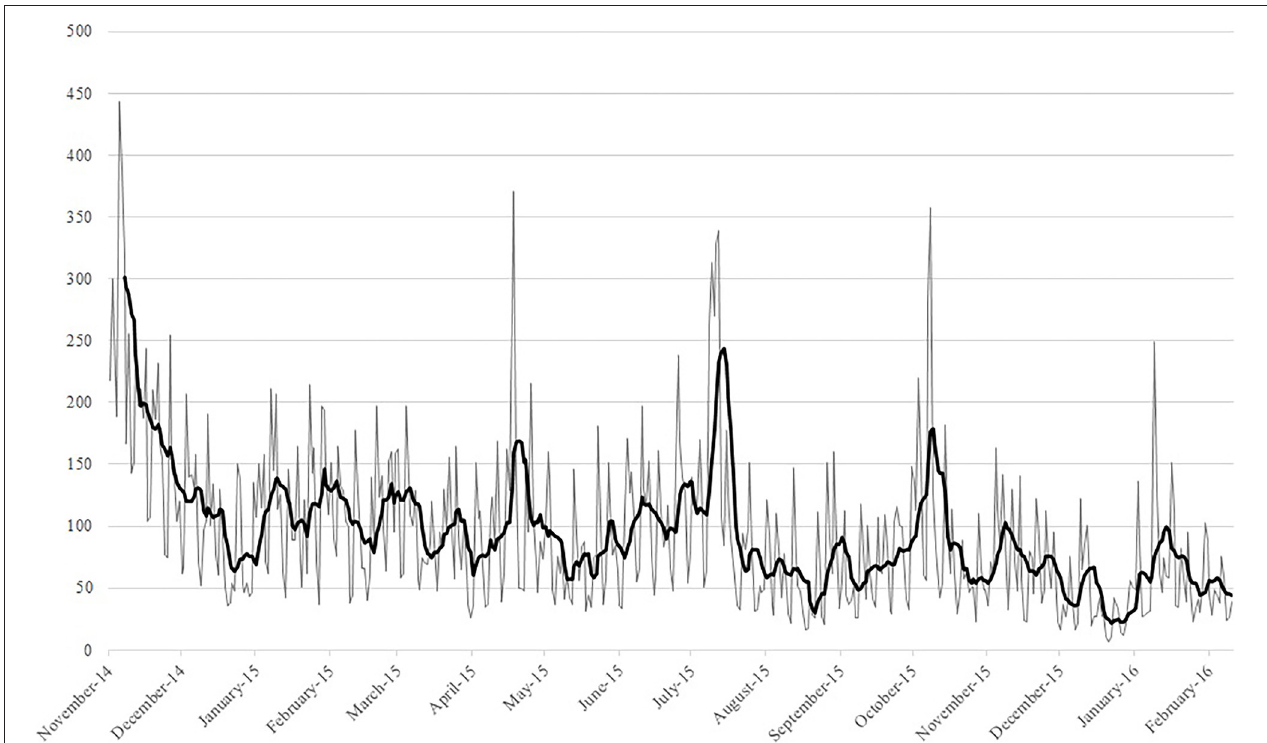
FIGURE 2 | IRC daily sessions from November 6, 2014, until February 15,